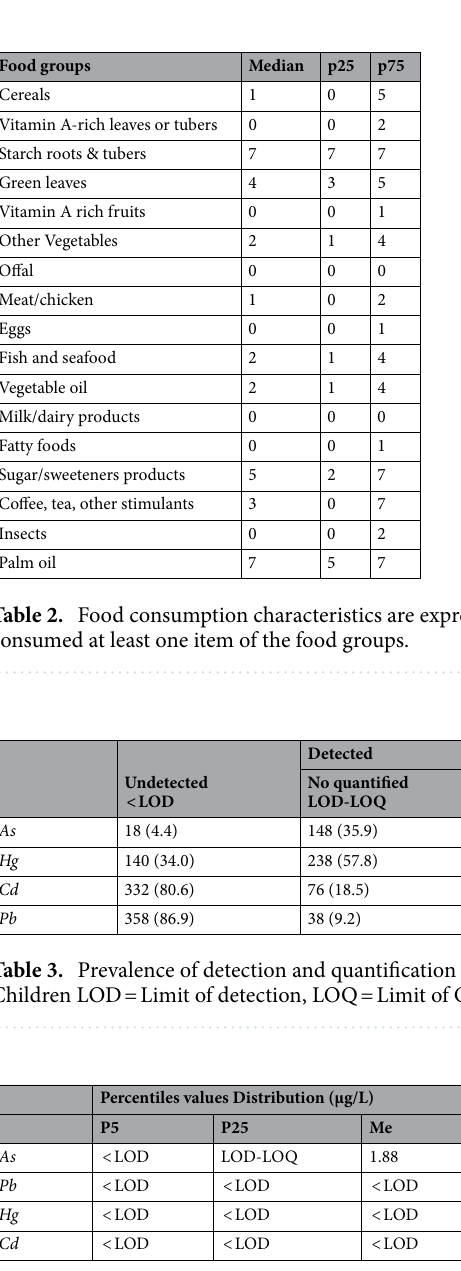
Table 4. Percentile value distribution of heavy metals in Popokabaka Children (μg/L). LoD for As 0.2 μg/L, LoQ for As 0.55 μg/L; LoD for Pb 0.6 μg/L, LoQ for Pb 2.1 μg/L; LoD for Hg 0.2 μg/L, LoQ for Hg 0.83